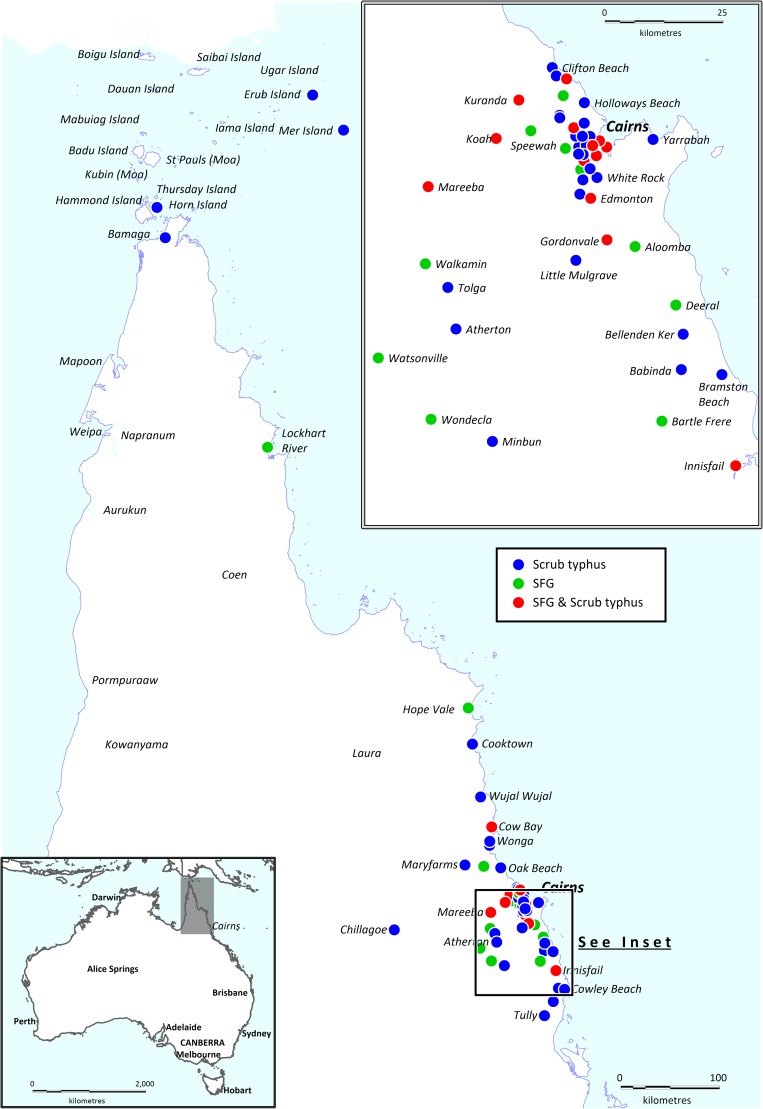
Spatial distribution of cases of rickettsial infections hospitalised at Cairns Hospital during the study period.Note the location of each case is based on the residential address of the patient, not necessarily the location of acquisition, which was frequently impossible to determine in this retrospective study. The map was created using constructed using mapping software (MapInfo version 15.02, Connecticut, USA) using data provided by the State of Queensland (QSpatial). Queensland Place Names—State of Queensland (Department of Natural Resources, Mines and Energy) 2019, available under Creative Commons Attribution 4.0 International licence https://creativecommons.org/licenses/by/4.0/. ‘Coastline and state border–Queensland - State of Queensland (Department of Natural Resources, Mines and Energy) 2019, available under Creative Commons Attribution 4.0 International licence https://creativecommons.org/licenses/by/4.0/. Note Erub Island is also known as Darnley Island.